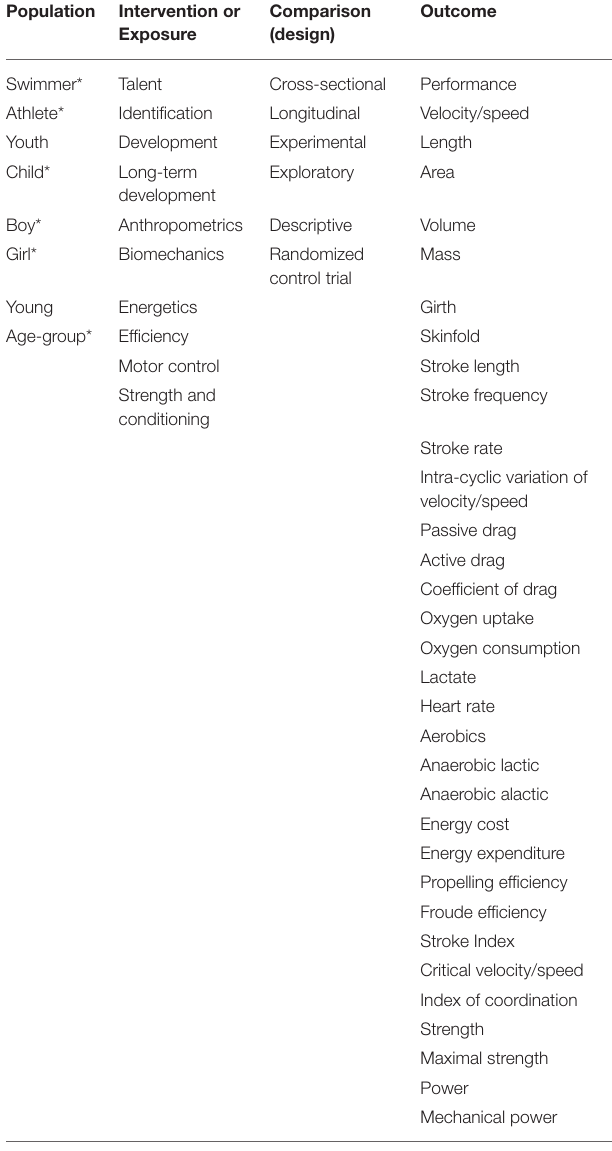
TABLE 1 | PI(E) CO (P—patient, problem or population; I—intervention; E—exposure; C—comparison, control, or comparator; O—outcomes) search